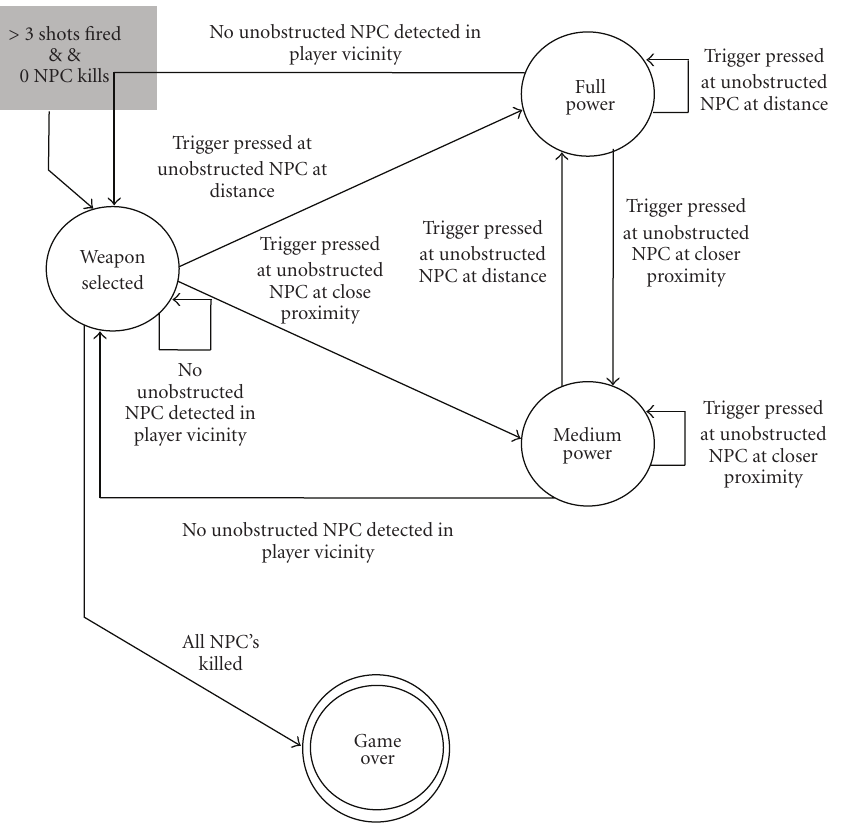
Figure 5: Proposed autonomous weapon directional control